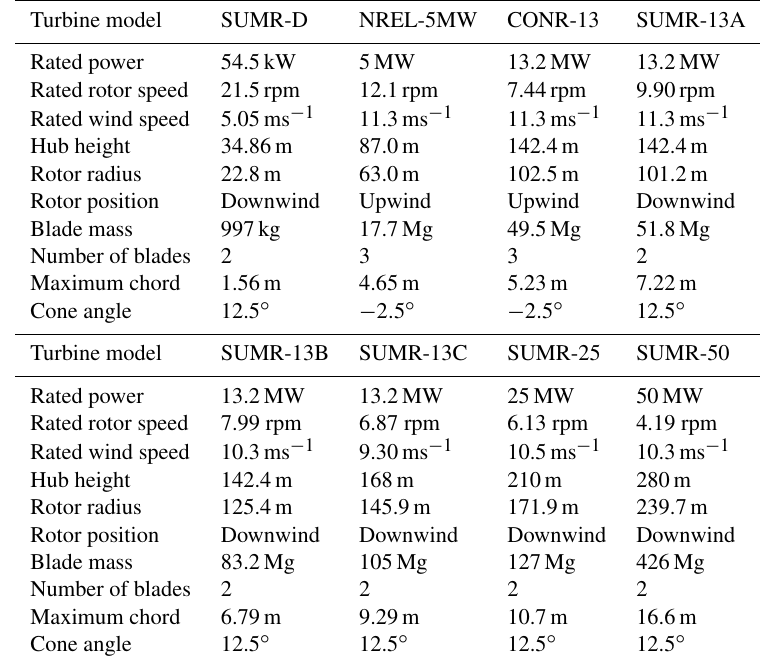
Table B1. Summary of turbine models used in this